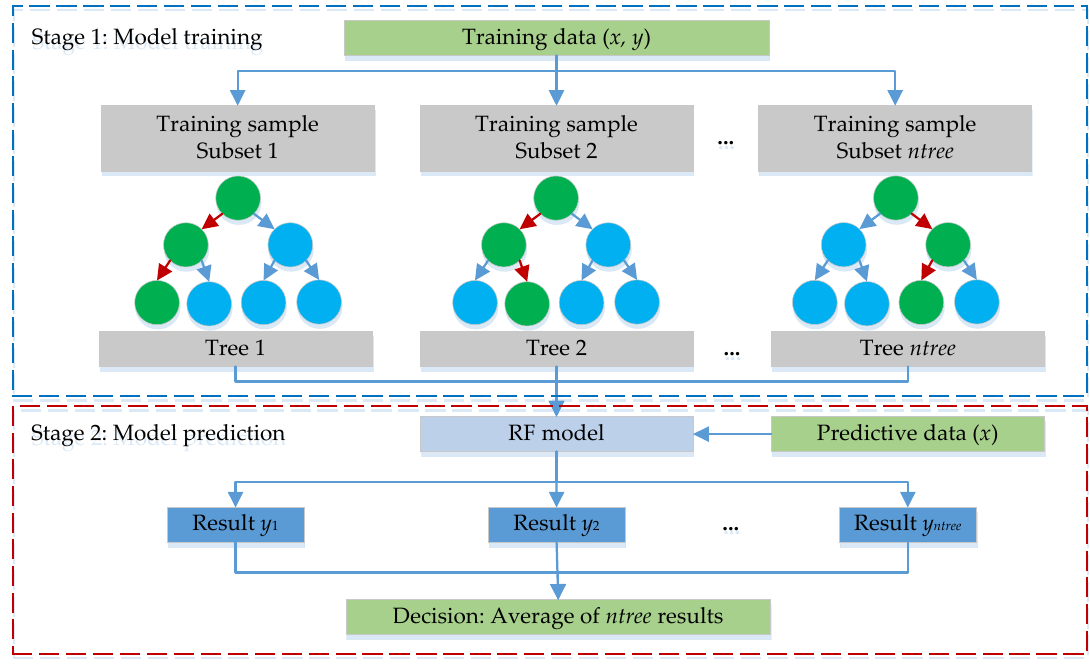
Figure 1. Schematic representation of RF analysis.